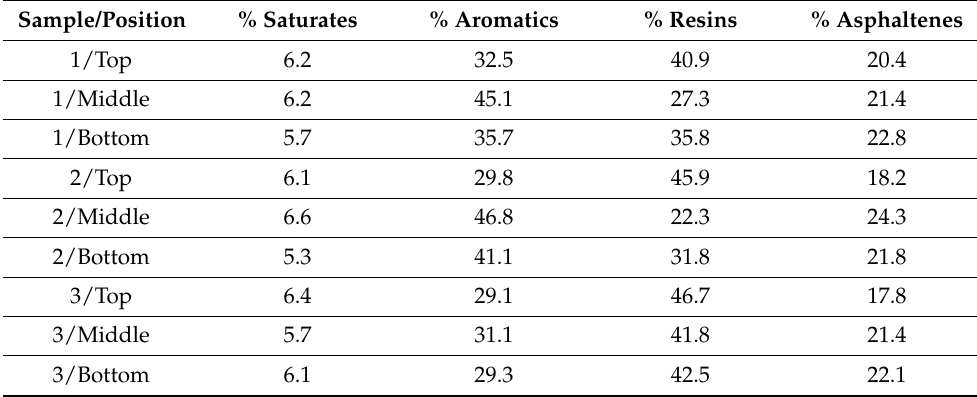
Table 6. Iatroscan SARA analysis results of oven aged samples.